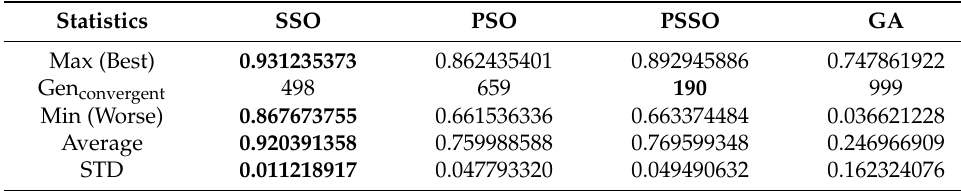
Table 4. The statistics of system reliability for benchmark 1.